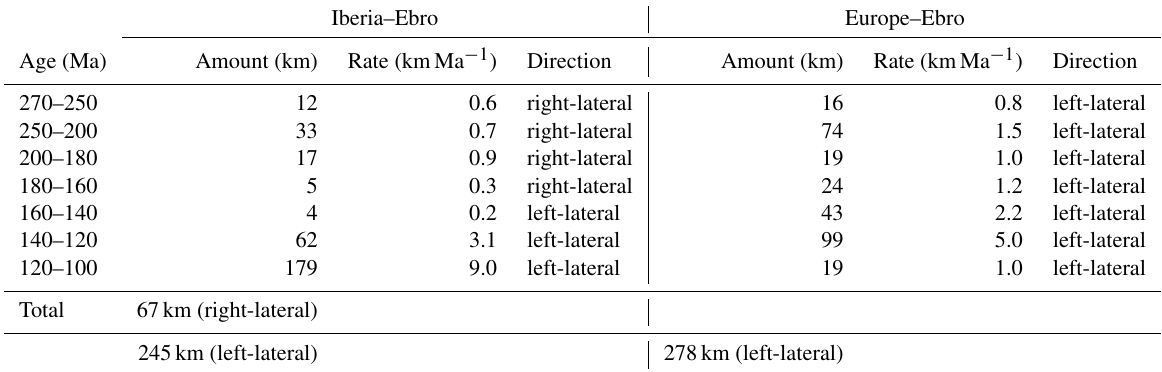
Table 3. Quantification of strike-slip displacement between the European and Ebro and between the Iberia (Galicia) and Ebro.